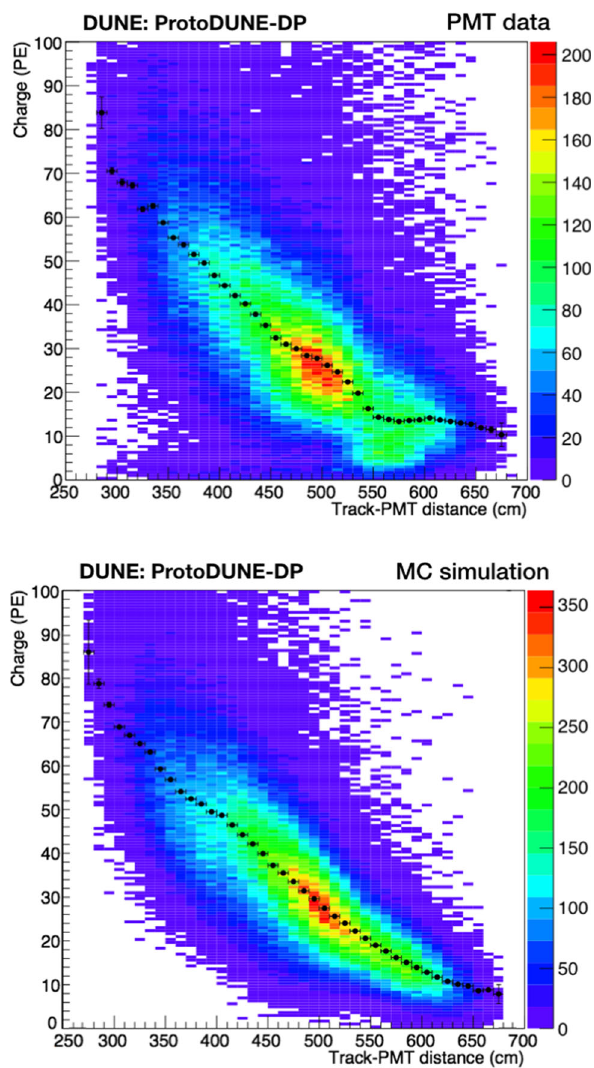
Fig. 15 Collected S1 charge versus track-PMT distance for PEN PMTs: Light data (top) and MC sample (bottom). The color maps con- tain all the S1 signals detected by the PMTs and passing the event selection. A Gaussian fit of each charge-distribution every 10cm is per- formed and the mean values are plotted in black over the map. The vertical error bars correspond to errors from the fits and a 5-cm distance uncertainty (horizontal error bars) is